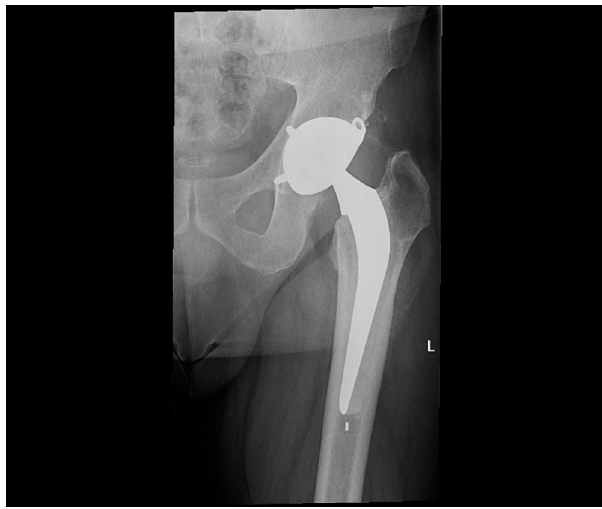
Figure 3. Post-operative X-ray.